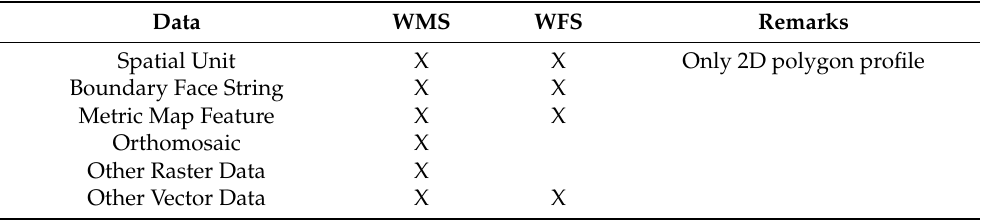
Table 2. Spatial data classes in PaS (X indicates support).